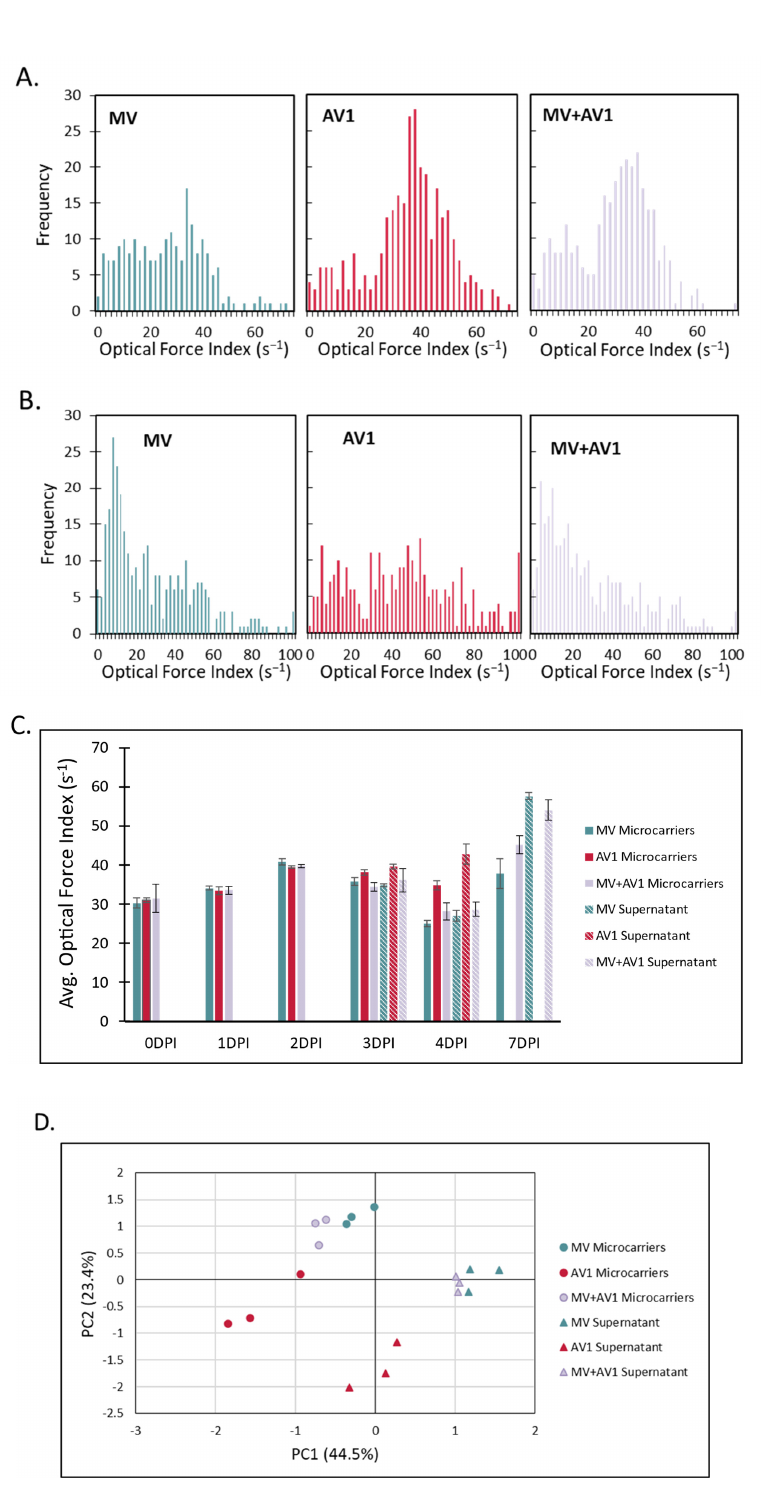
Figure 4. LumaCyte Radiance demonstrated the ability to identify differences in cell samples sup- plied from 3 L bioreactors infected with MV alone, AV1 alone, and a combination of MV + AV1. ( A ). Representative OFI histograms from microcarriers samples for MV, AV1, and MV + AV1 coinfection at 96 h post infection. ( B ). Representative OFI histograms from supernatant samples for MV, AV1, and MV + AV1 coinfection at 96 h post infection. ( C ). Population average OFI for microcarriers and supernatant samples across the production time course for MV, AV1, and MV + AV1 coinfection (error bars represent technical replicates n = 3). ( D ). Principal component analysis for MV, AV1, and MV + AV1 samples using Radiance data. Each point represents a sample analyzed with LFC from either the microcarriers or supernatant samples at 96 h post infection.